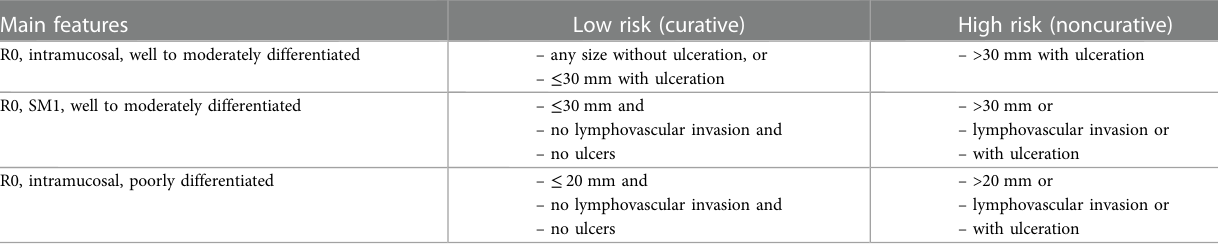
TABLE 1 Distinction between curative and noncurative endoscopic resection of early gastric cancers. Main